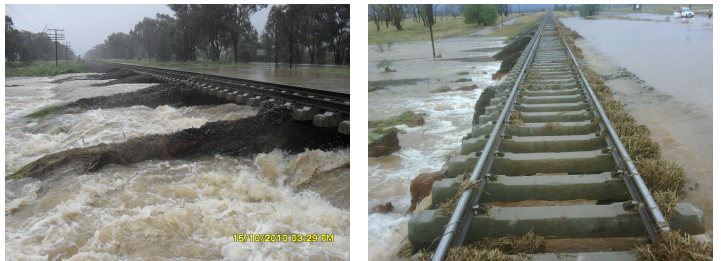
Figure 1. Scouring of railway ballast during flooding in the Hunter Valley, NSW, Australia, in October 2010. Copyright Australian Rail Track